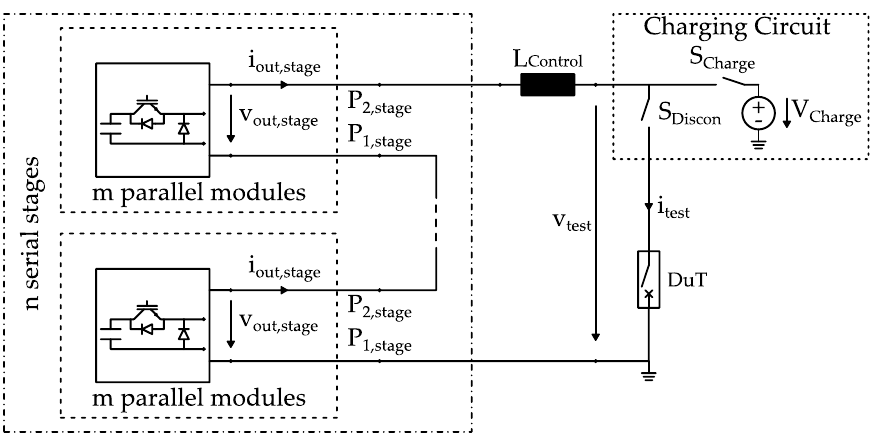
Figure 6. Schematic circuit diagram of integrated overall test circuit with test current ( i test ) and voltage ( v test ) applied on a device under test ( DuT ).